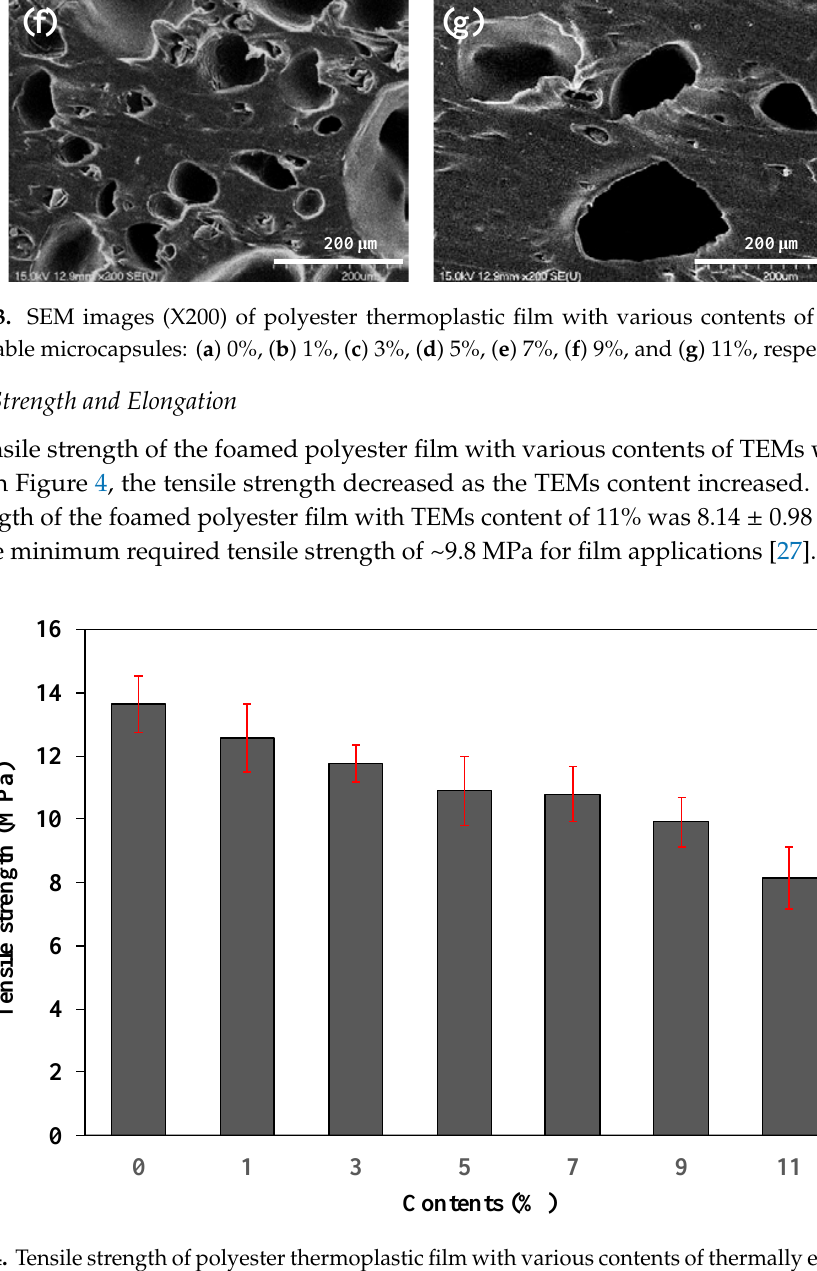
Figure 4. Tensile strength of polyester thermoplastic film with various contents of thermally expandable microcapsules.